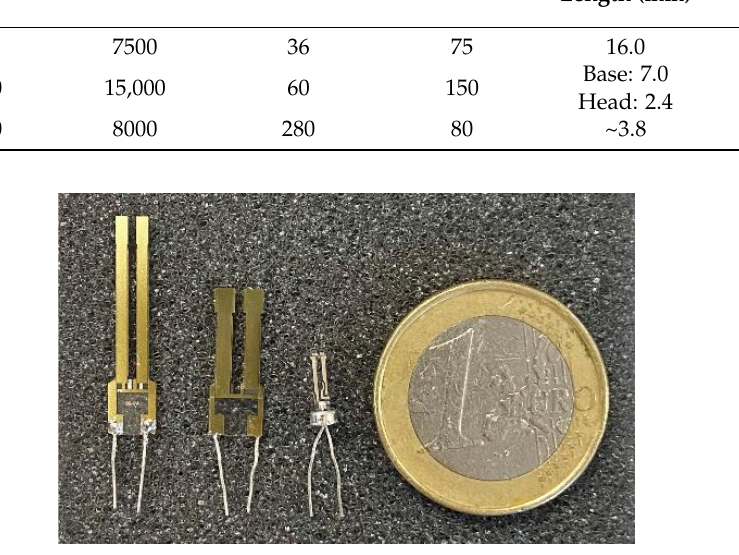
Figure 2. From left to right a sample of each QTF is presented: AV-08, T1-08, commercial.